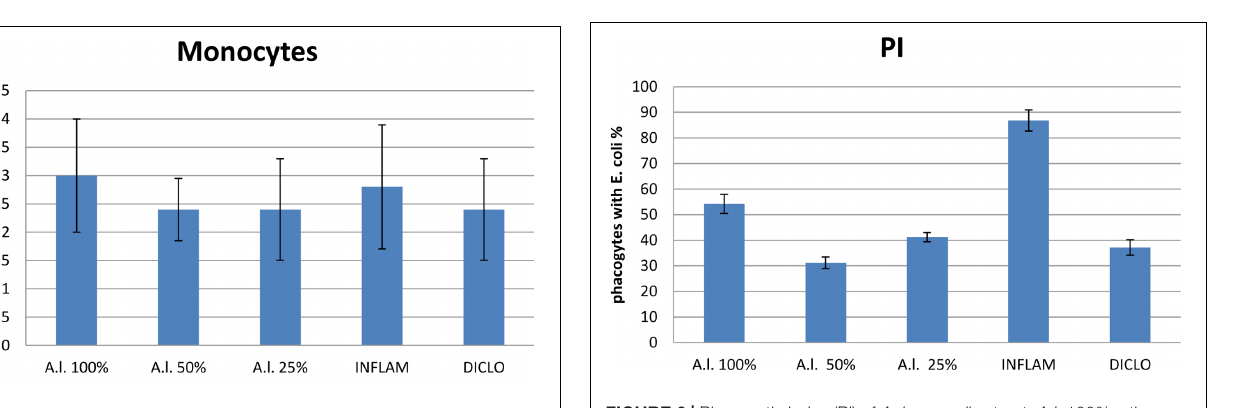
FIGURE 4 | Total number of monocytes. A.l. 100% – the animals received 5 mL/kg BW A. laxmannii ethanol extract 100% (100 mg dw/mL), A.l. 50% – the animals received 5 mL/kg BW A. laxmannii ethanol extract 50% (50 mg dw/mL), A.l. 25% – the animals received 5 mL/kg BW A. laxmannii ethanol extract 25% (25 mg dw/mL), Inflam – Inflammation was induced by i.m. injection of turpentine oil (6 mL/kg BW), Diclo – the animals received 20 mg/kg BW diclofenac ( p < 0.001).